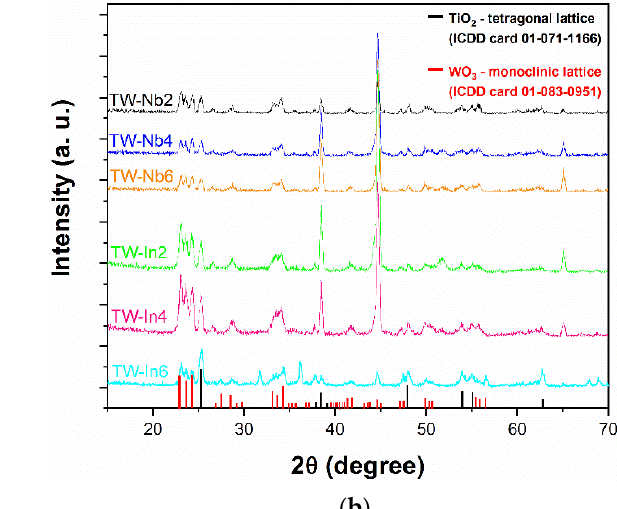
Figure 3. SEM images of 𝑁𝑏 -doped ( a ) 𝑇𝑊 − 𝑁𝑏2 , ( b ) 𝑇𝑊 − 𝑁𝑏4 and ( c ) 𝑇𝑊 − 𝑁𝑏6 and 𝐼𝑛 -doped ( e ) 𝑇𝑊 − 𝐼𝑛2 , ( f ) 𝑇𝑊 − 𝐼𝑛4 and ( g ) 𝑇𝑊 − 𝐼𝑛6 sintered MMO; EDX elemental composition and mapping of ( d ) 𝑇𝑊 − 𝑁𝑏4 and ( h ) 𝑇𝑊 − 𝐼𝑛4 sensors.